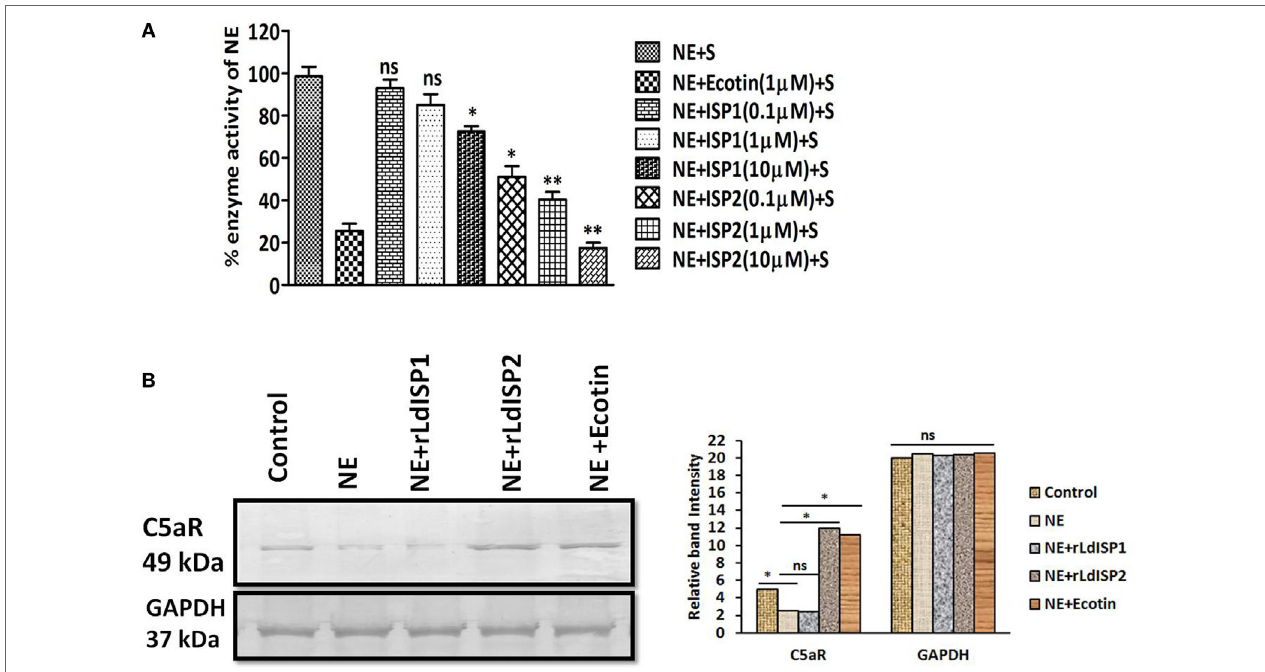
FigUre 7 | Effect of LdISPs on neutrophil elastase (NE) and C5aR expression. The inhibitory effect of rLdISPs (rLdISP1 and rLdISP2) on NE was accessed by enzymatic assay (a) . NE was either left untreated or treated with ecotin (1 µM) or rLdISP1/rLdISP2 (0.1–10 µM) and incubated on ice for 30 min followed by subsequent addition of chromogenic substrate. Enzymatic hydrolysis of the substrate was monitored by measuring the release of fluorescence (excitation 380 nm, emission at 460 nm) in the spectrofluorometer. (B) Macrophages were either left untreated or treated with NE (10 µg/ml), or NE pre-incubated with an inhibitor such as ecotin (1 µM) or rLdISP1/rLdISP2 (10 µM) followed by incubation for 2 h at 37°C. The expression of C5aR was analysed by western blot. GAPDH was used as an endogenous control. Densitometric analysis was done to monitor the relative band intensity. The experiments were performed in triplicate and data are means ± SD from three separate experiments. The blot image is representative of a single experiment. Kruskal–Wallis test with Dunn’s multiple comparisons was performed. An asterisk (*) denotes P ≤ 0.05 and a double asterisk (**) denotes P ≤ 0.001 when compared to control.